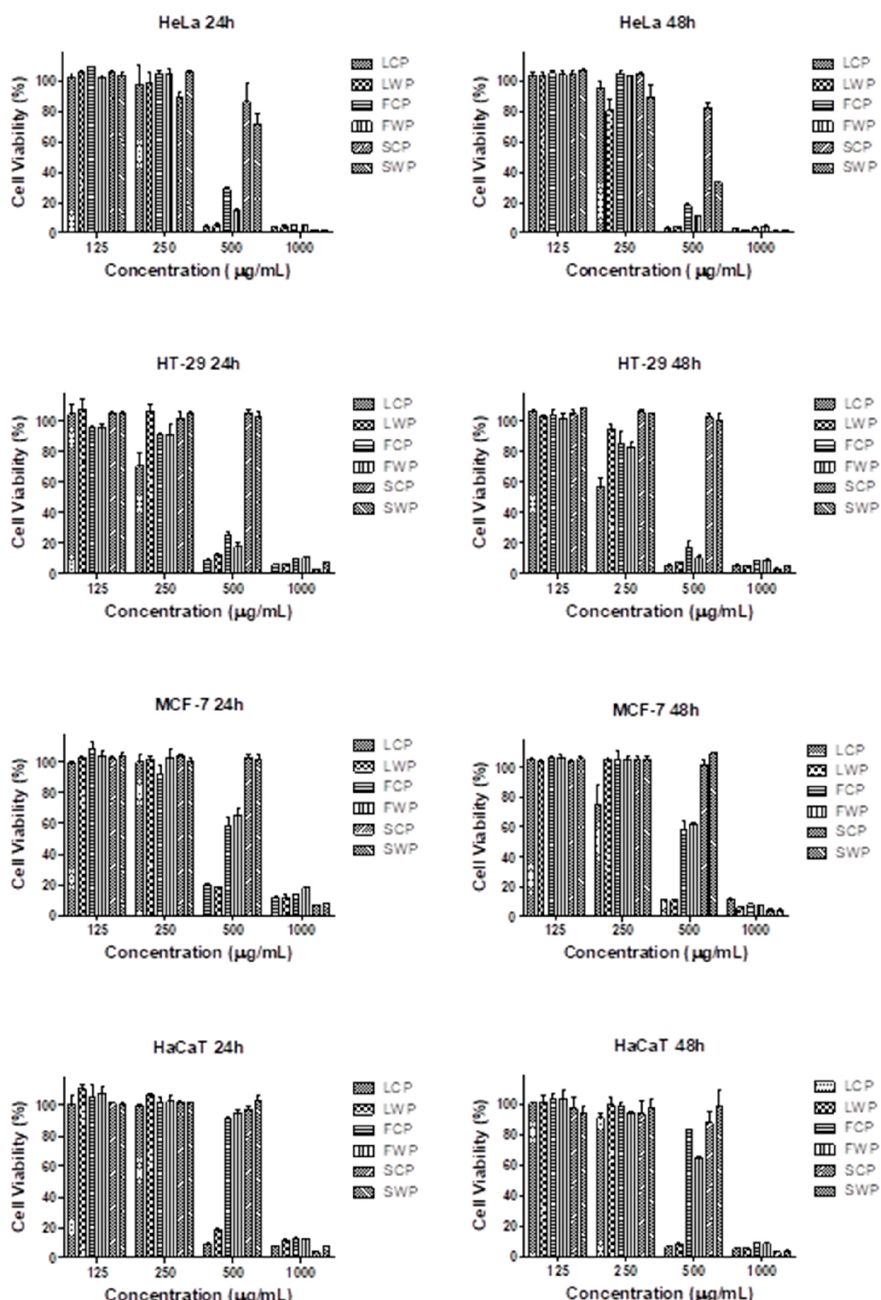
Figure 3. Effects of C. vulgare extracts on the cell viability of HeLa, HT-29, MCF-7 and HaCaT cell lines as assessed by MTT test after 24 and 48 h of exposure.